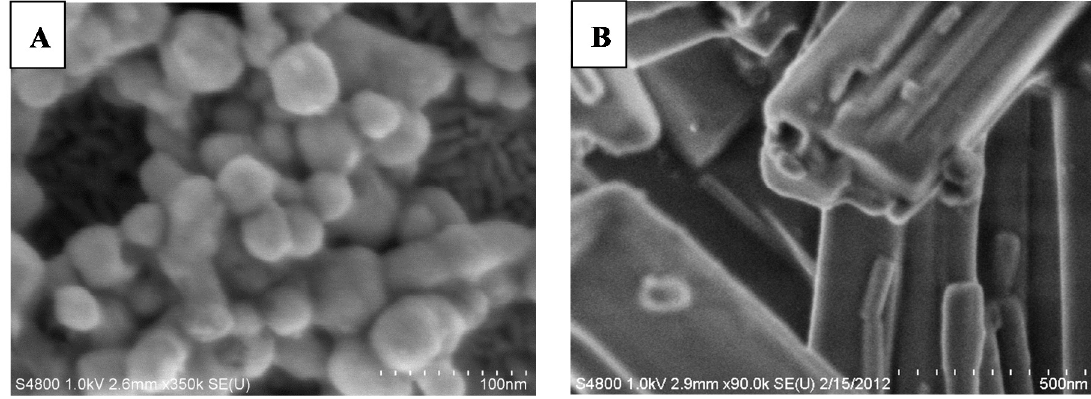
Figure 4. Scanning electron micrographs of synthesized MOBs: ( A ) AgCysNPs, scale bar indicates 100 nm with 10 nm gradations; ( B ) CuHARS, scale bar indicates 500 nm with 50 nm gradations.